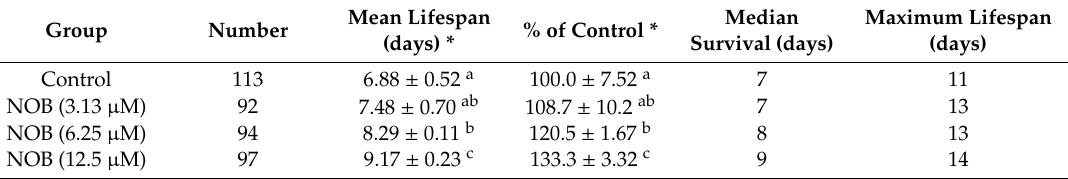
Table 3. E ff ect of NOB on UV radiation of C. elegans.